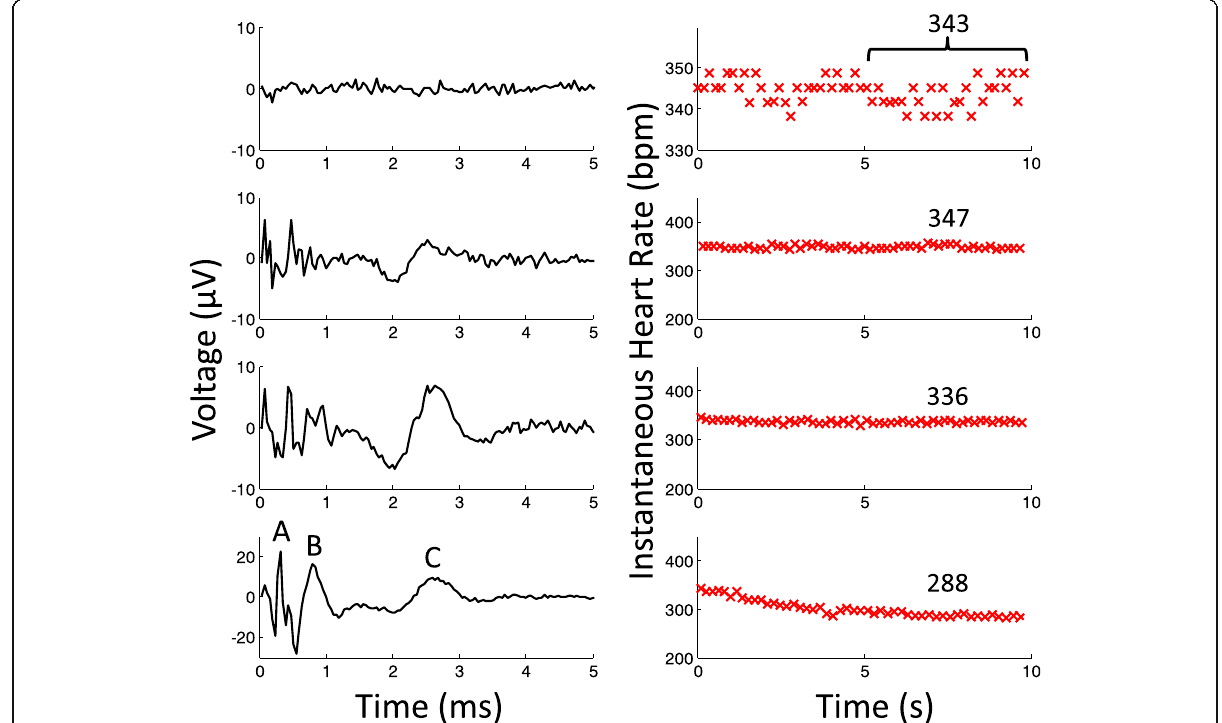
Fig. 2 Sample CNAP with corresponding heart rate measurement. Left) Averaged CNAP from the same waveform at increasing intensities (charge per phase from top to bottom: 0, 6nC, 12nC, 24nC). Right) The instantaneous heart rate data during the 10-s trial. The heart rate values during the last 5 s were averaged to produce a representative value for the trial (annotated, in bpm). Note the different Y-axis scales in certain